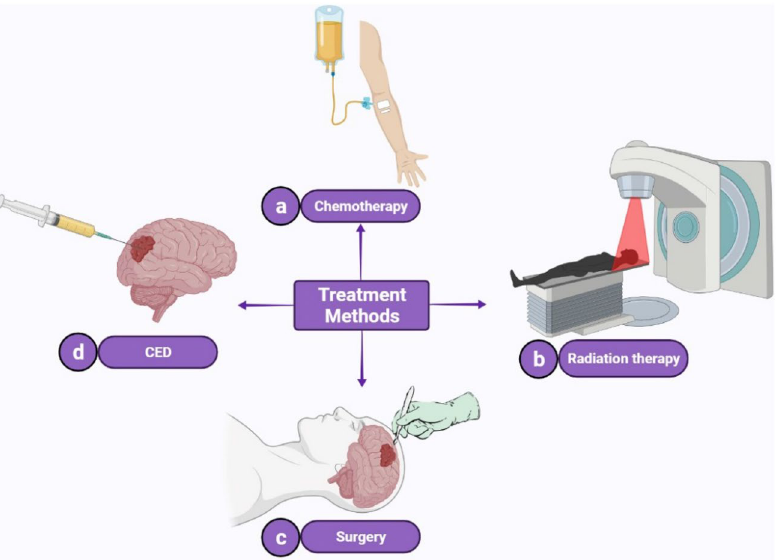
Figure 1. Different treatment strategies of brain tumors. In chemotherapy, the drug solution is injected into the blood circulatory system ( a ). In radiation therapy, X-ray or gamma-ray is radiated to the tumor cells to destroy them ( b ). Using surgical approaches, an expert opens the skull to remove the tumor ( c ). As for conventional drug delivery methods, the drug solution is injected directly to the tumor site via a thin catheter in CED ( d